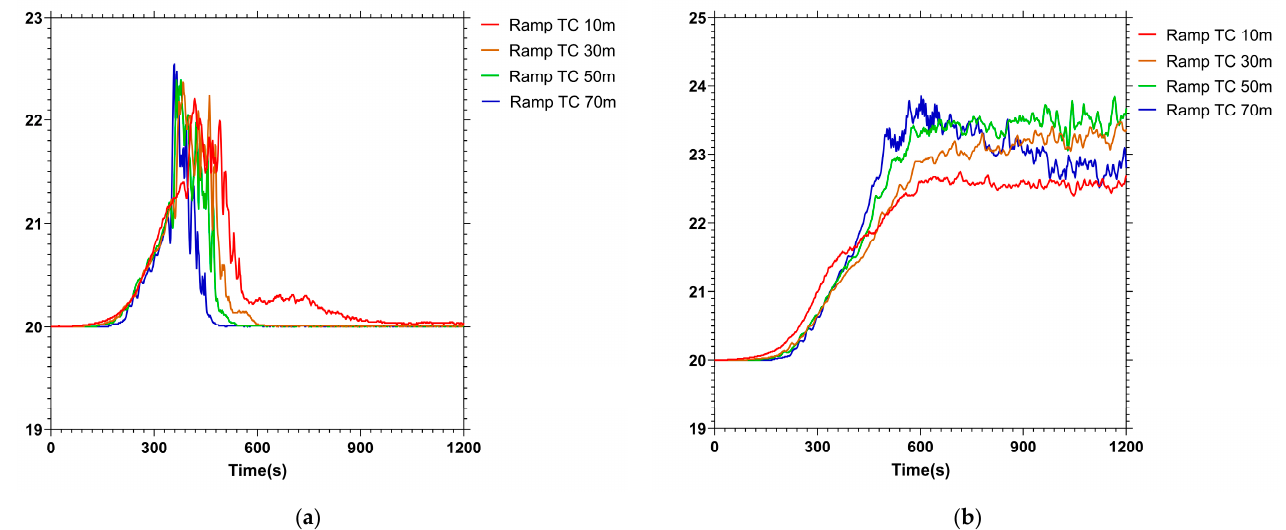
Figure 4. Upwind fire temperature distribution at y = 0.5 m (symmetry plane of the walking platform) and 2 m height for ( a ) the ventilated scenario and ( b ) the non- ventilated scenario. The temperature does not exceed 24 degrees; thus, the evacuation can be carried out.